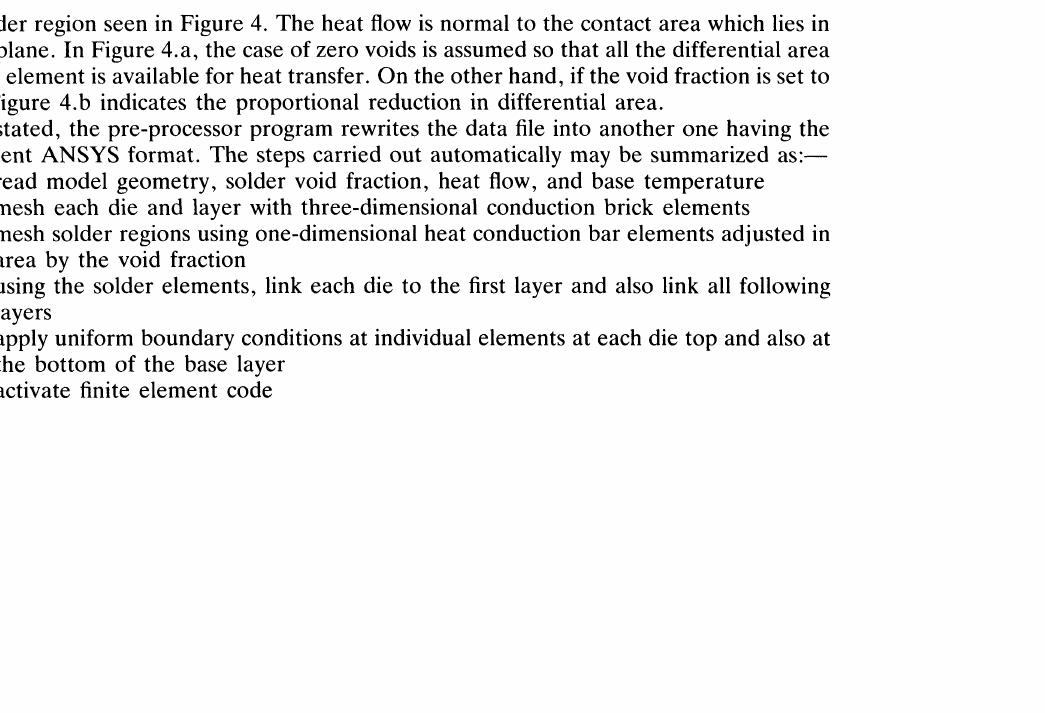
FIGURE 3. Top-view outline of somc module die and layer